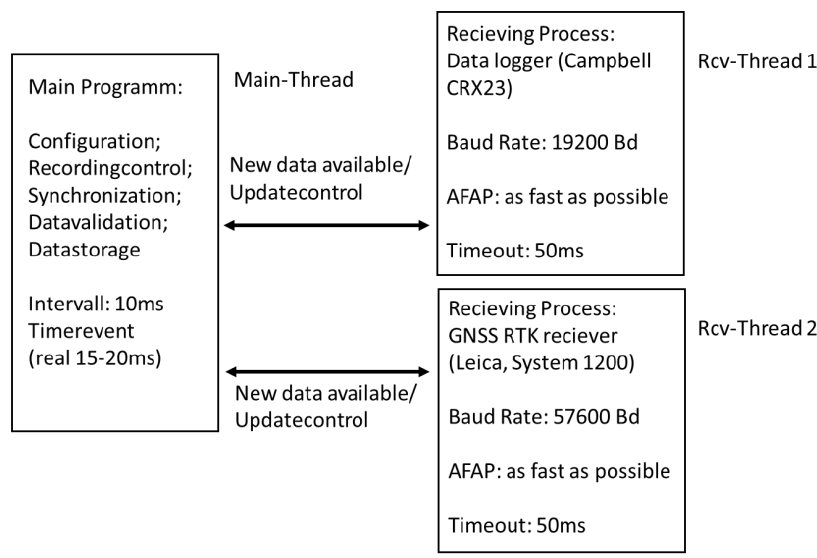
Figure 2. Flow chart of data